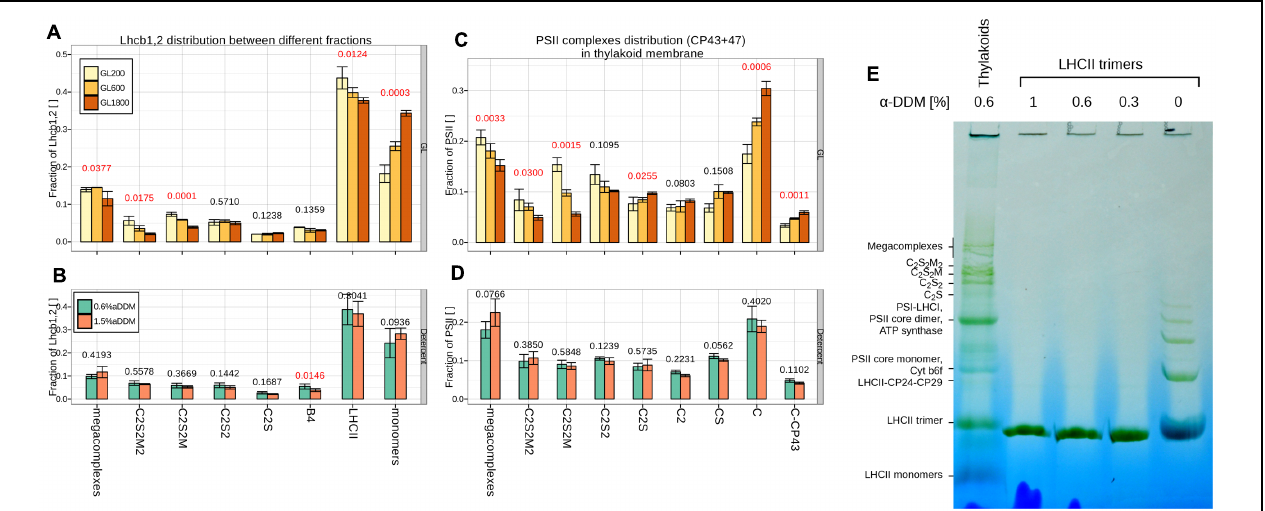
FIGURE 4 | Growth light (GL) and detergent influence on PSII complexes and Lhcb1, 2 distribution. The distribution of PSII between different PSII complexes according to the Lhcb1,2 (A,B) : supercomplexes (megacomplexes, C 2 S 2 M 2 , C 2 S 2 M, C 2 S 2 , C 2 S), different complexes (CP29 + LHCII + CP24 complex, B4; Light Harvesting complex of PSII, LHCII) and monomers or CP43 and CP47 (C,D) : supercomplexes (megacomplexes, C 2 S 2 M 2 , C 2 S 2 M, C 2 S 2 , C 2 S, CS) or different core complexes (core dimers, C 2 ; core monomers, C; core monomers without CP43, C-CP43) in isolated thylakoids separated during 2D-PAGE and quantified from three different gels ( n = 3). Thylakoids were taken from plants grown under GL200, 600, and 1800 (respectively, yellow, orange, and brown fill; A,C panels) or only GL200, but were solubilized in 0.6 and 1.5% α -DDM (respectively, green and blue cyan fill; B,D panels). Numbers above the bars are the p -values of ANOVA’s F -test on a specific group. Red color signifies rejection of the null hypothesis that the response to all GLs is the same ( α < 0.05), black its acceptance. (E) BN-PAGE of thylakoids solubilized in 0.6% α -DDM and LHCII trimers (3 μ g of Chl) solubilized in 0, 0.3, 0.6, and 1% of α